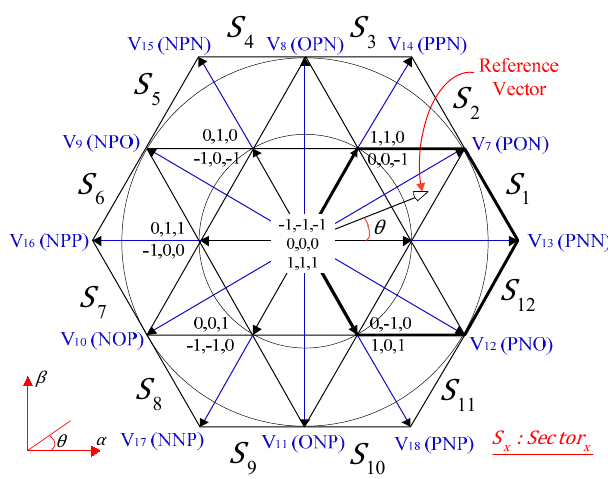
Figure 8. Switching states of the proposed algorithm.